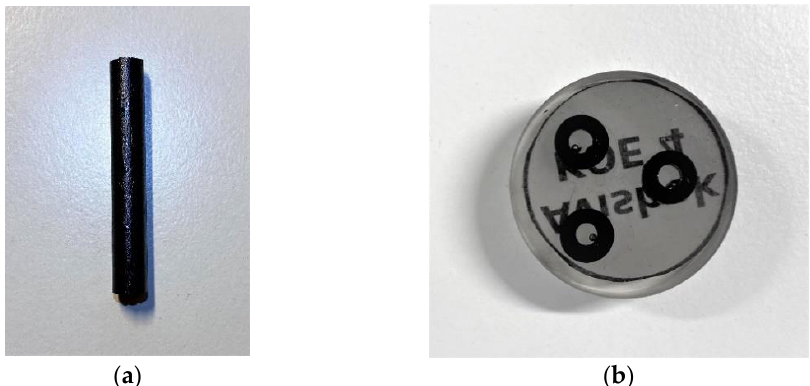
Figure 6. ( a ) Water quenched slag sample. ( b ) The cross-section of the slag sample showing the inner and outer surface regions.